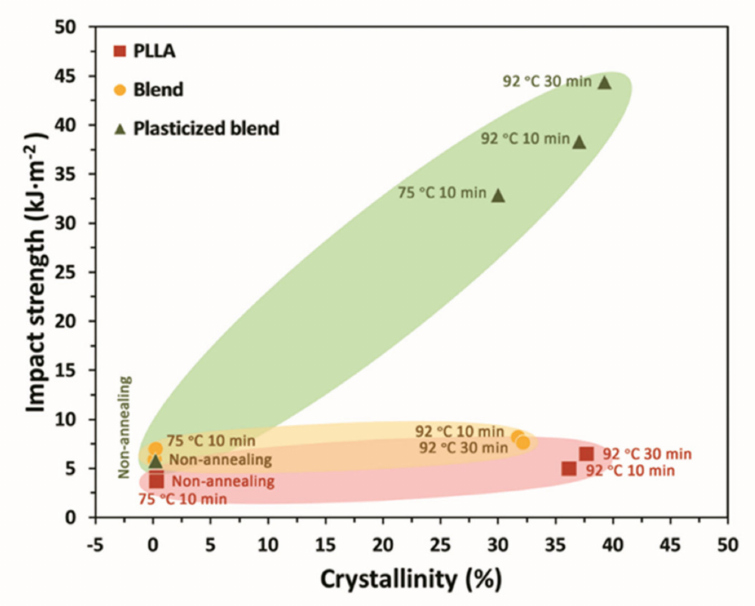
Figure 3. Relationship between crystallinity and notched Izod impact